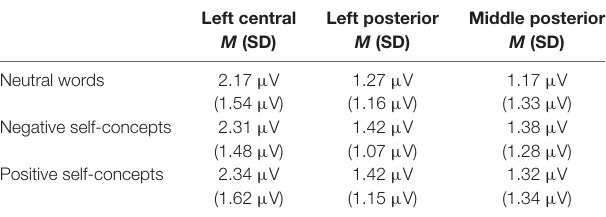
TABLE 2 | The average P300 amplitudes and standard deviations for neutral words, negative self-concepts and positive self-concepts words over different